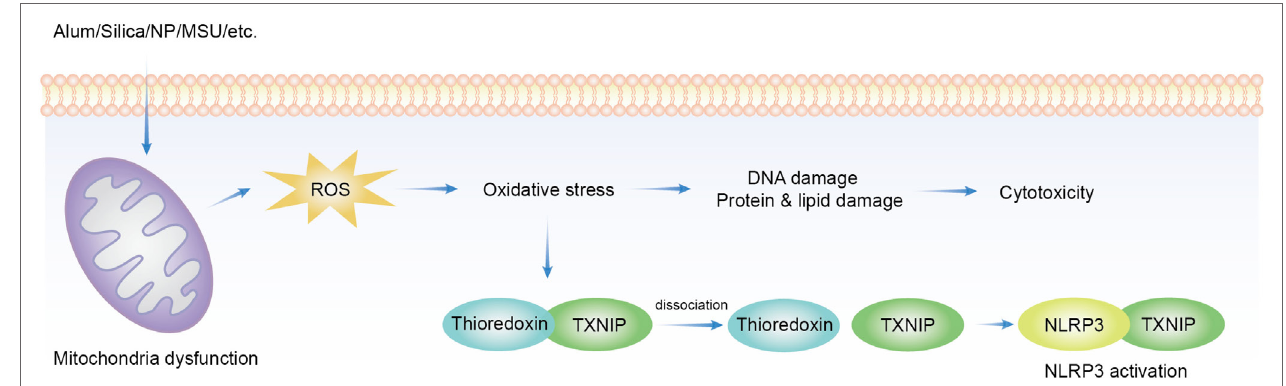
FiGURe 1 | Overview of reactive oxygen species (ROS) implicated in solid particle-induced cell death and NACHT, LRR, PYD domains-containing protein 3 (NLRP3) inflammasome activation. Solid particle treatment causes mitochondrial stress and ROS production. The oxidative stress mediates the damage of DNA, proteins, and lipids, which may be an important cause of cytotoxicity. ROS production also induces NLRP3 inflammasome activation by dissociating thioredoxin-interacting protein (TXNIP) from thioredoxin then allows its binding to NLRP3, which leads to NLRP3